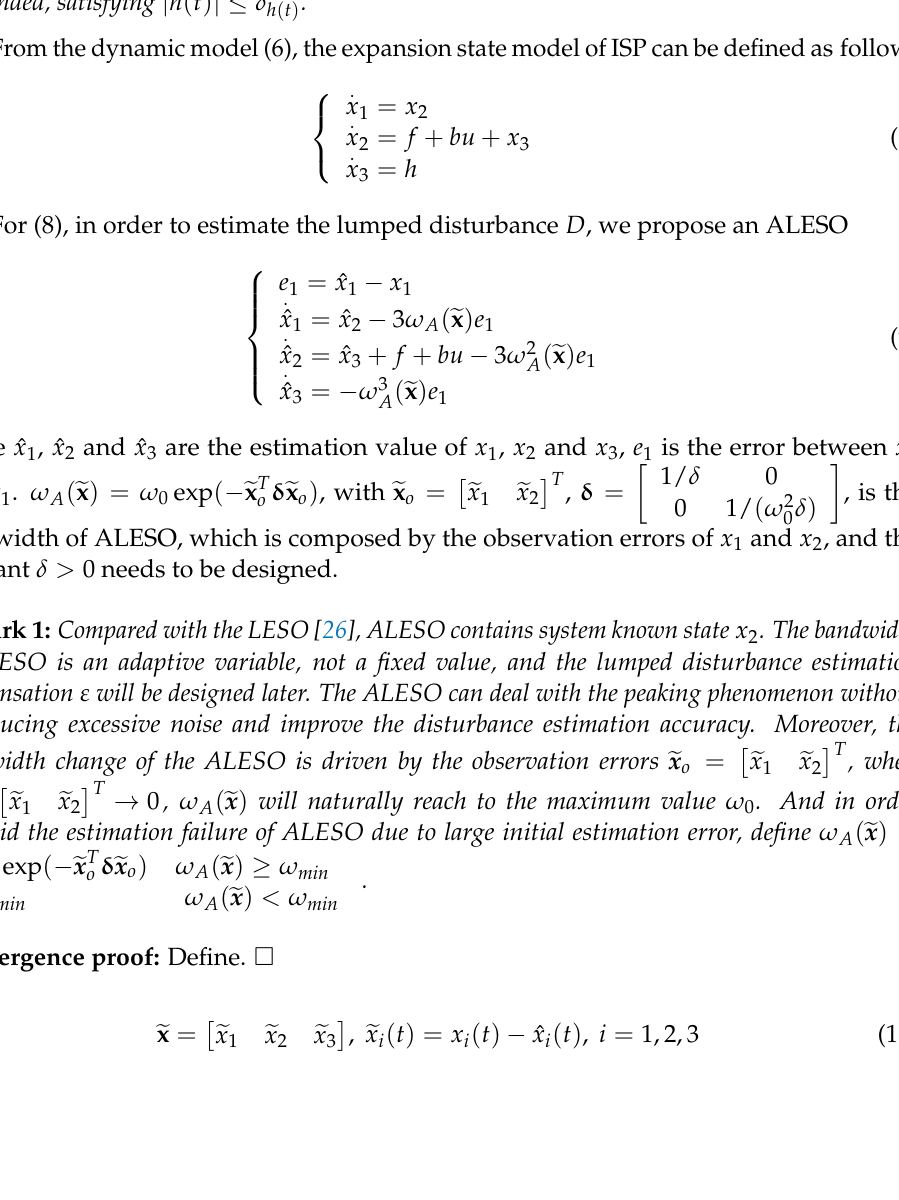
Define the lumped disturbance D gd  . For the dynamic model of ISP system, let are the state variables.